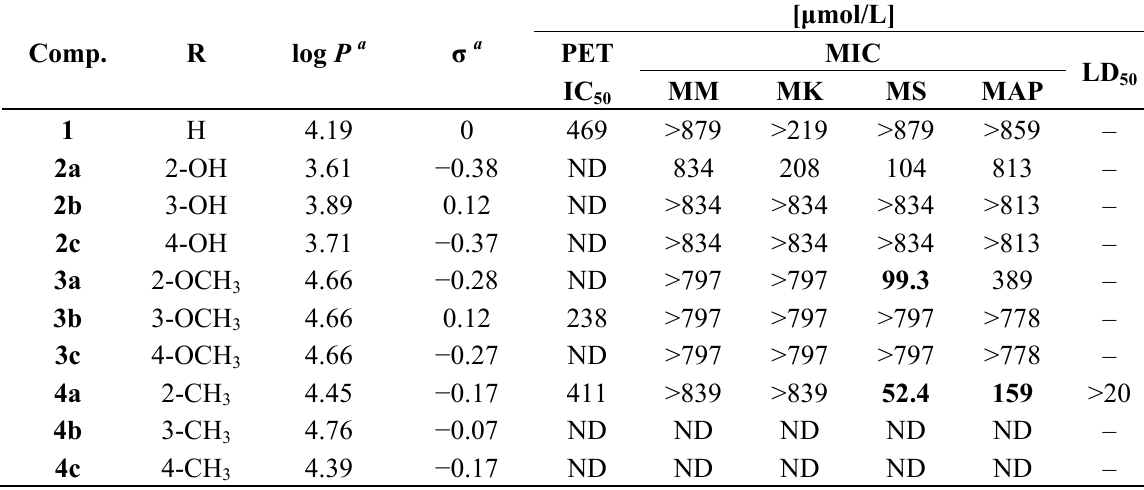
Table 1. Structure of ring-substituted 4-arylamino-7-chloroquinolinium chlorides 1 – 9c